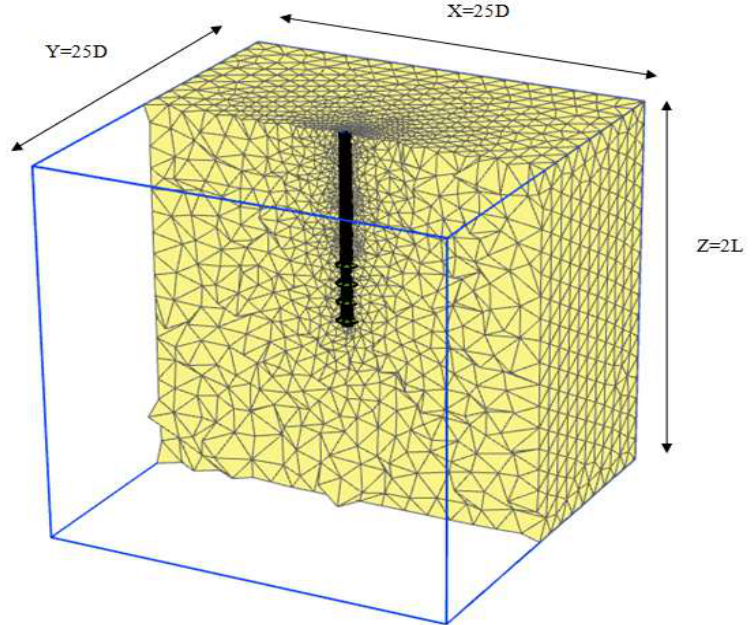
Figure 4. Generated Mesh with mesh dimensions.